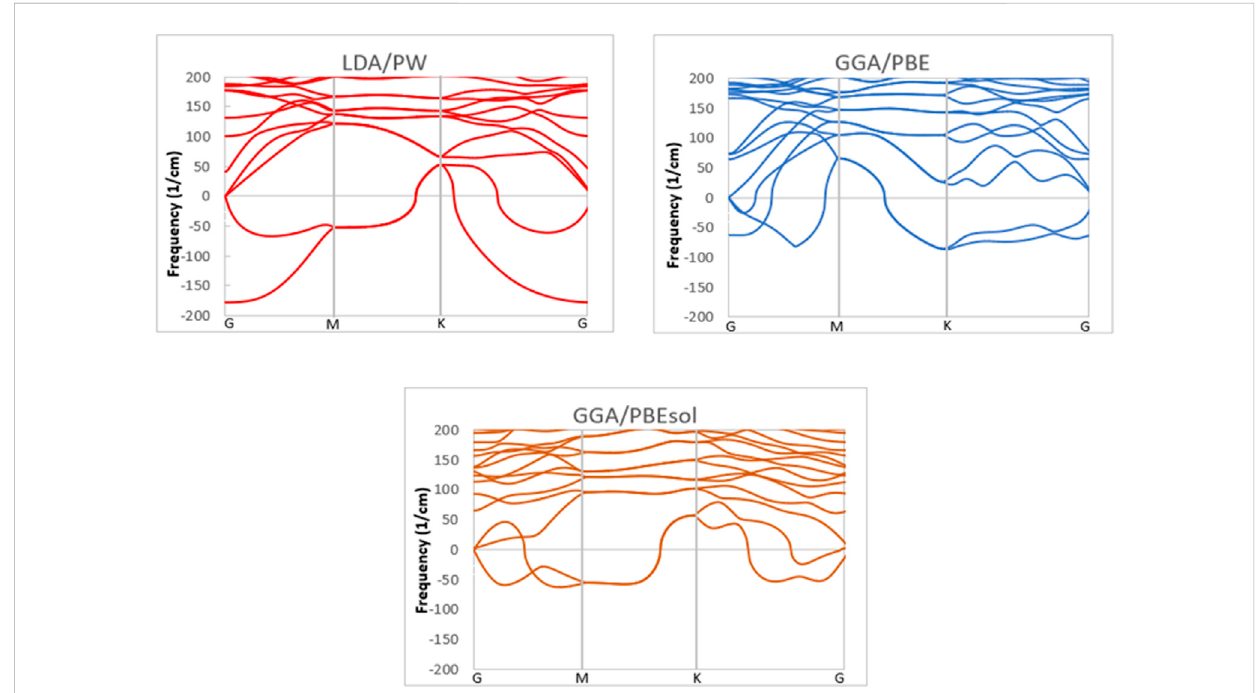
FIGURE 3 Phonon dispersion of the VO 2 (M) structure predicted by the LDA, PBE, and PBEsol functionals.